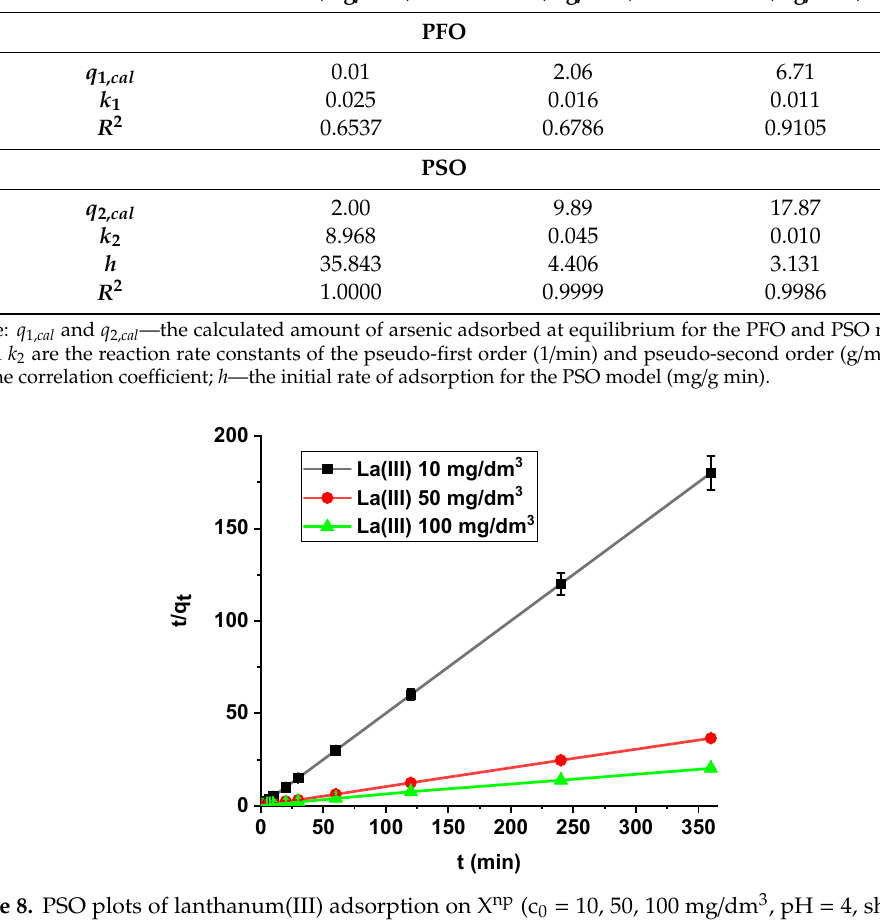
Figure 8. PSO plots of lanthanum(III) adsorption on X np (c 0 = 10, 50, 100 mg/dm 3 , pH = 4, shaking speed 180 rpm, temperature 295 K).